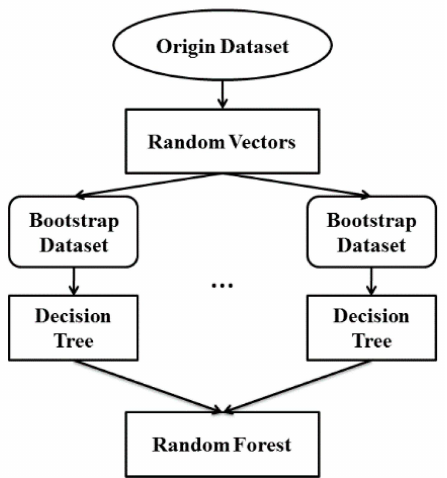
Figure 4. Structure of proposed random forest algorithm. The structure of the decision tree is detailed in Figure 5.